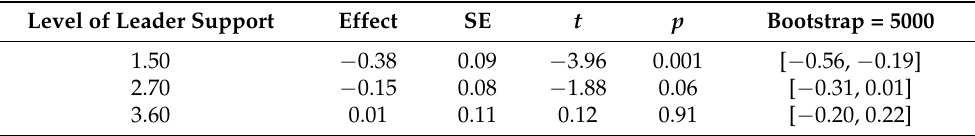
Table 6. Conditional effect of responsibility attribution on expected emotional exhaustion at different values of leader